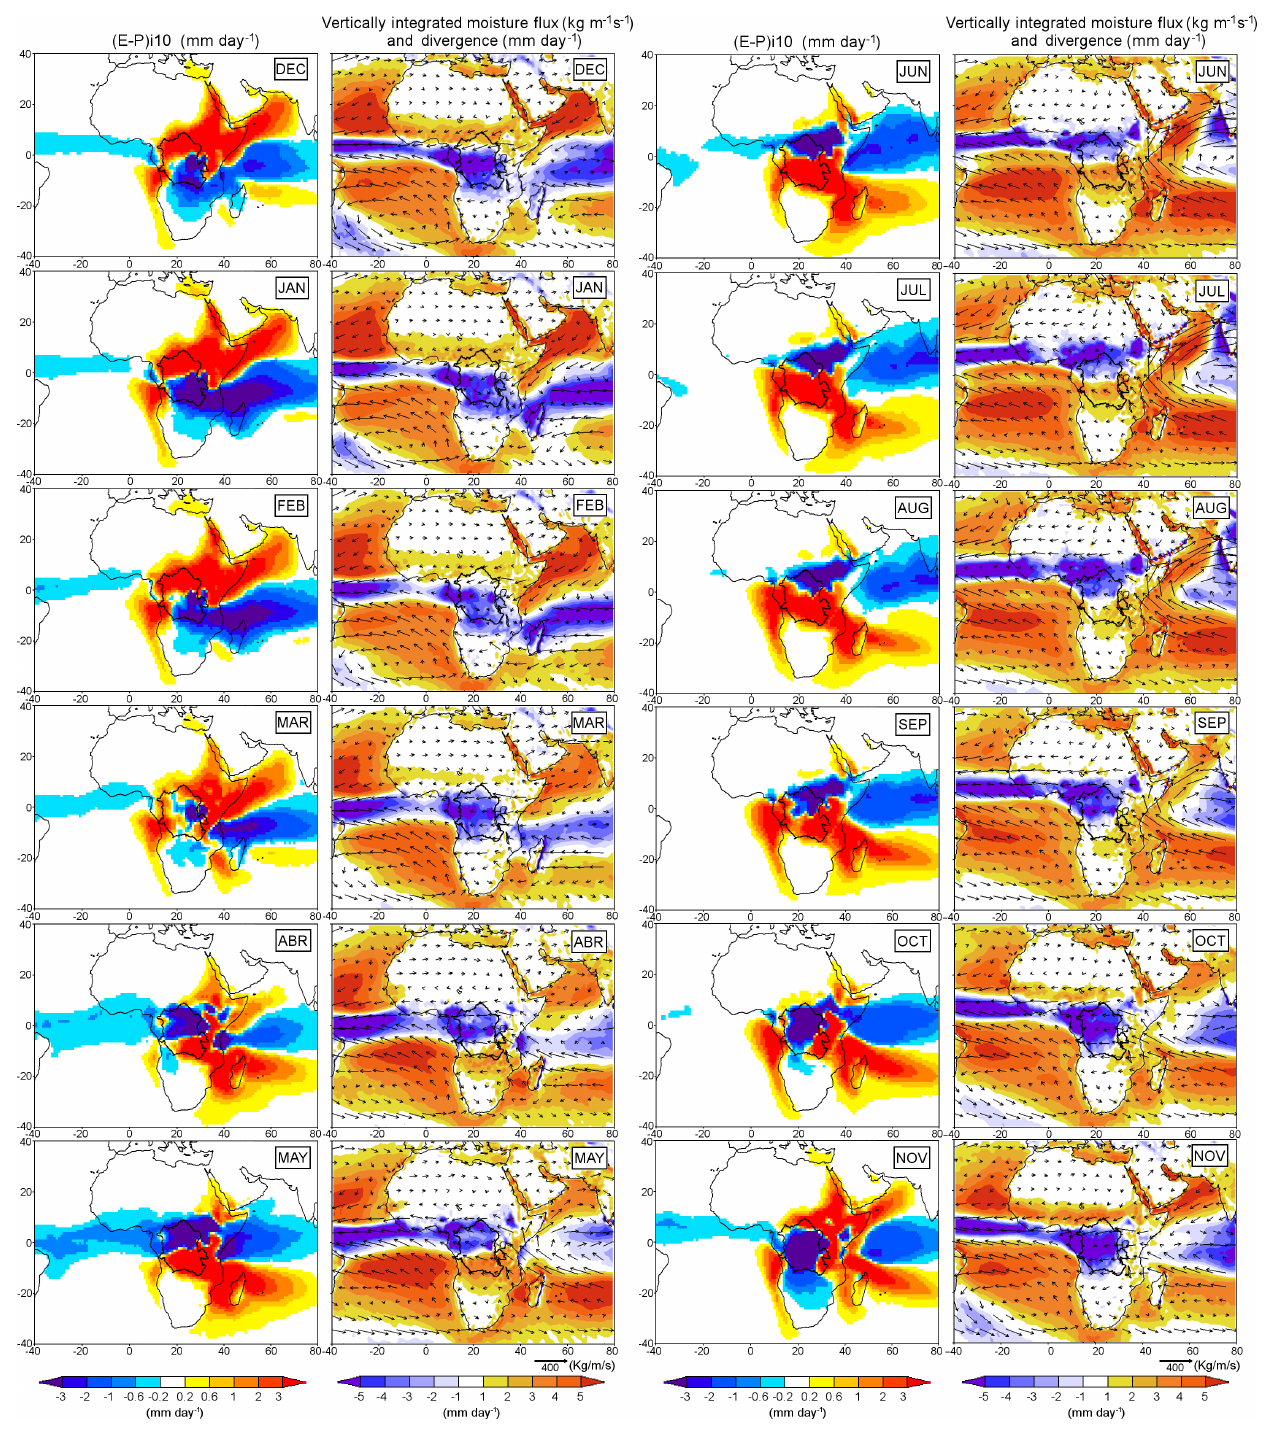
Figure 4. Monthly climatological ( E − P ) values integrated backward over 10 days (mmday − 1 ) alongside the vertically integrated moisture flux (kgm − 1 s − 1 ) and divergence–convergence (reddish-blueish colours) (mmday − 1 ). Period: 1980–2010.